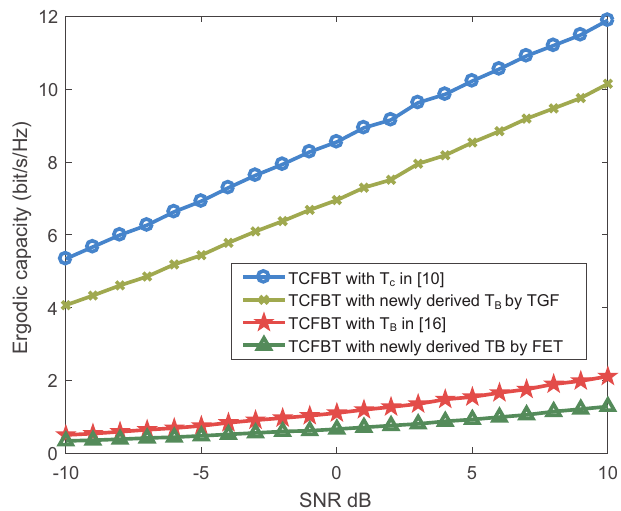
Figure 6. The ergodic capacity vs. SNR with v = 1 m/s.